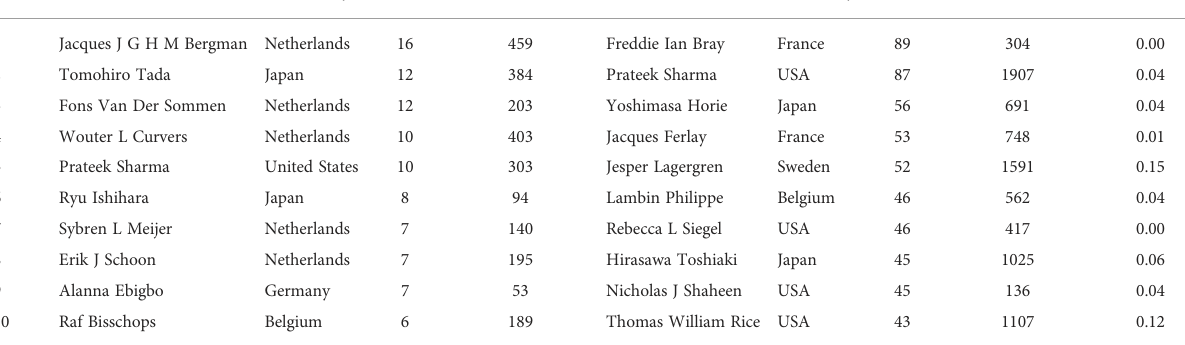
TABLE 3 The 10 most productive authors and the top 10 co-cited authors with the highest citations.